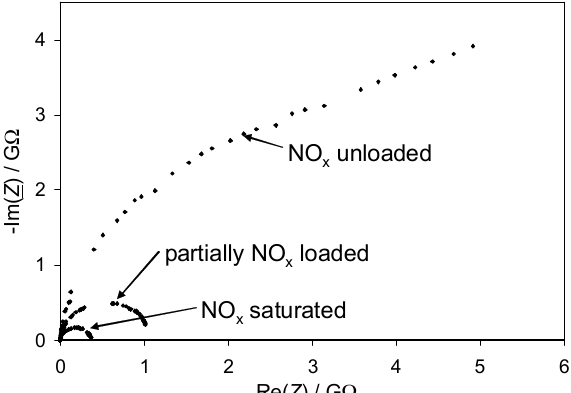
Figure 5. Impedance of an impedimetric sensor (see Figure 4) when loaded with different amounts of NO at 350 °C and gas compositions at a gas flow of 2 L/min: 10% O x